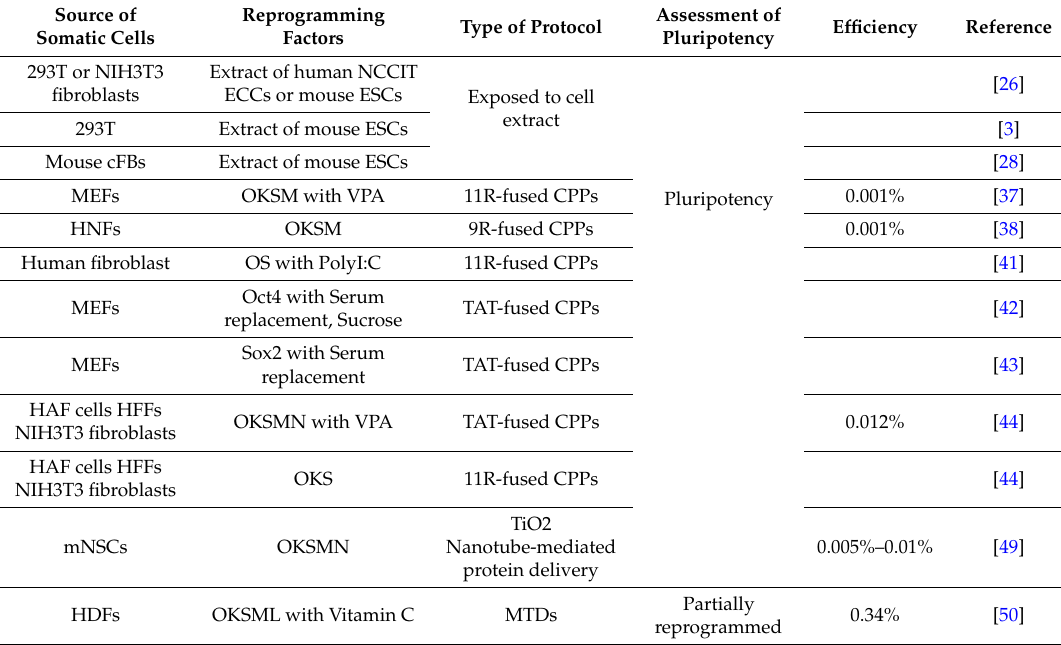
Table 1. Summary of non-integrative methodologies using